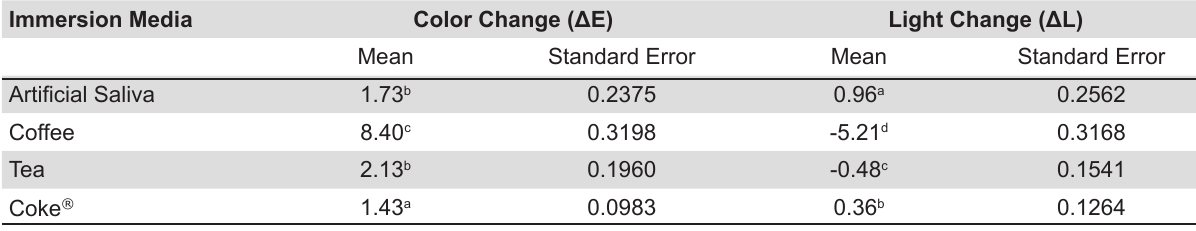
ΔE - gL=3; H=423.0867; p=0.000000 ΔL - gL=3; H=475.5569; p=0.000000 Similar letters indicate vertical statistical similarity (column). Table 3- Distribution of means and standard deviations (SD) of color change (ΔE) and light (ΔL) of the studied composite resin as a function of the time x immersion medium interaction